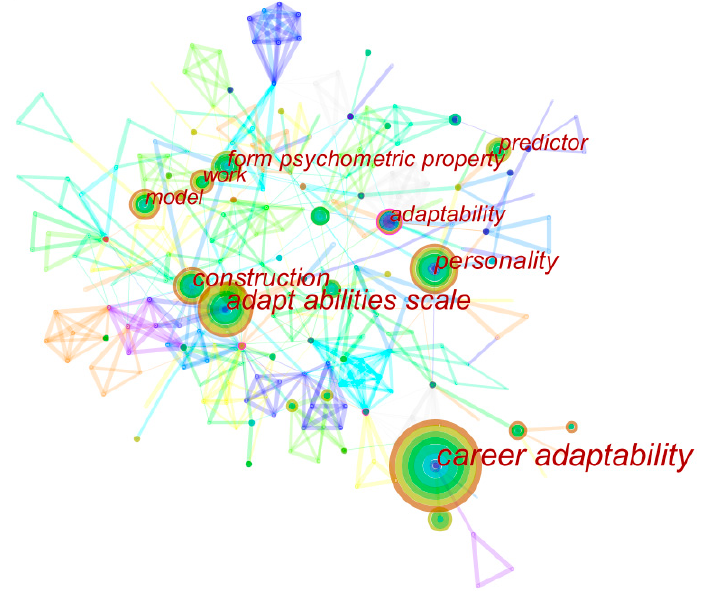
Figure 3. Co-occurrence map of keywords in career adaptability. Table 2. Ranking of 43 high-frequency keywords for career adaptability.